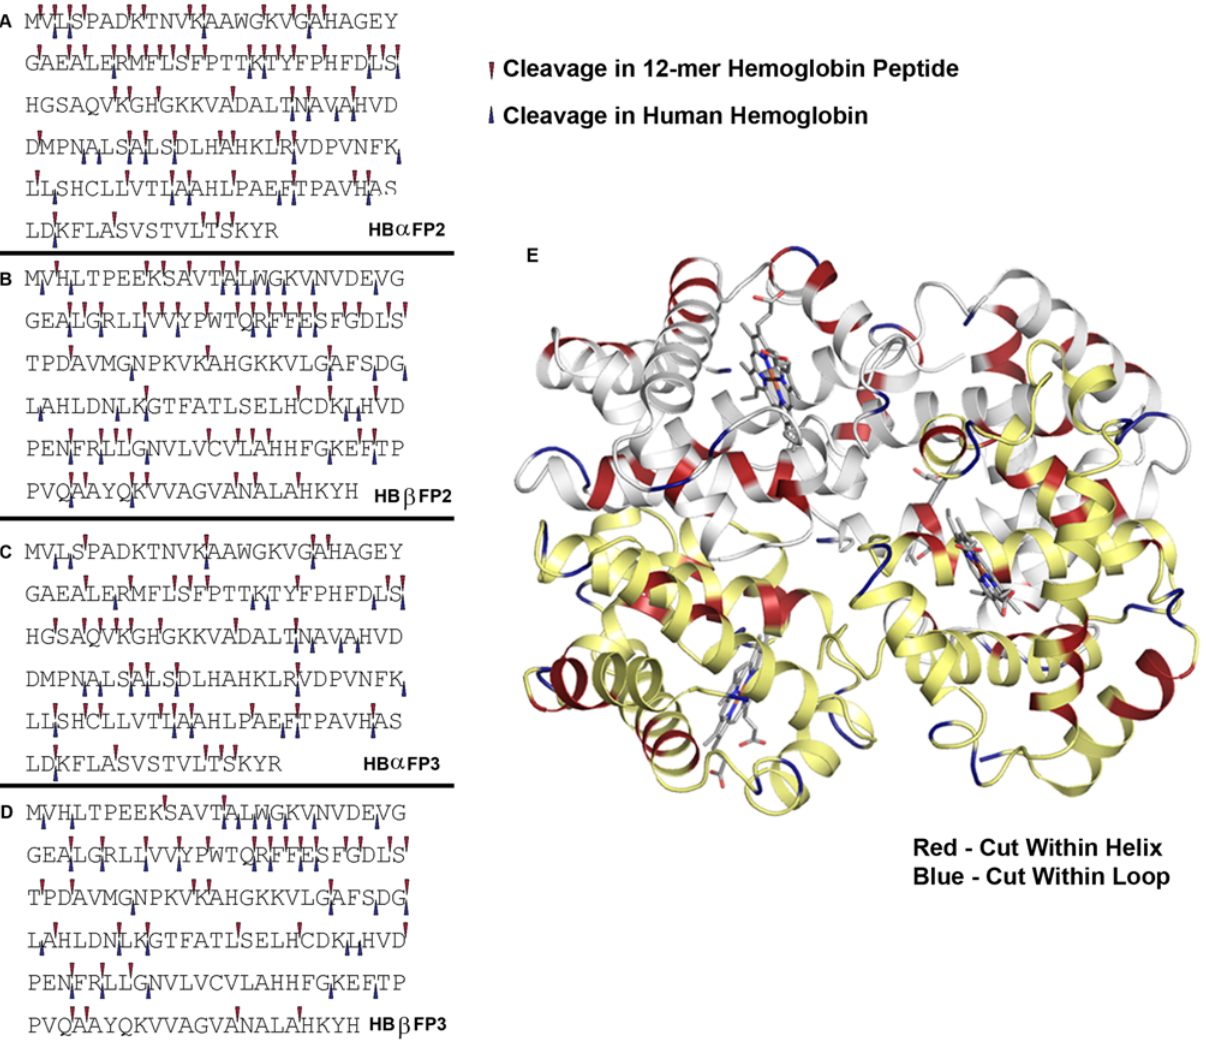
Figure 2. Hemoglobin cleavage sites for falcipain-2 and falcipain-3. A–D. Globin peptides and intact human hemoglobin. Cleavage sites for the two proteases based on analysis as described in Methods of hydrolysis of 12-mer peptides (top arrows, data from all time points) and intact hemoglobin (lower arrows, data from both 180 min and overnight time points) are shown for a and b globin. E. Intact human hemoglobin . The schematic shows a globin subunits in white and b globin subunits in yellow. P 1 residues at cleavage sites within helices are in red and within loops are in blue.